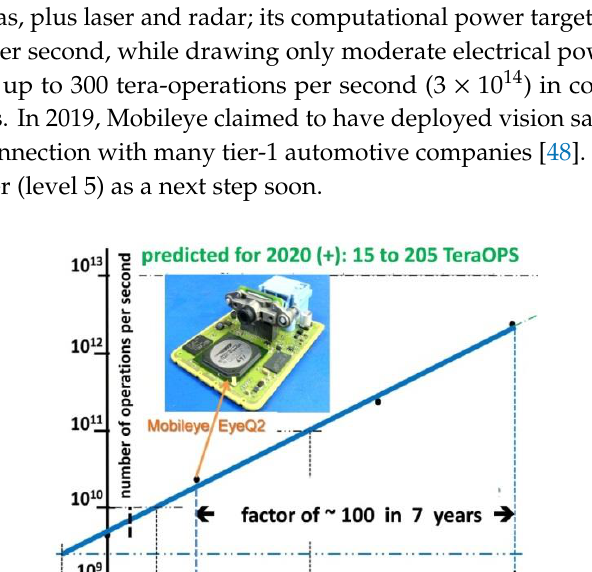
Figure 12. Agile multi-focal camera platform (left) as the main sensor, supported by a high-resolution 360° rotating laser scanner mounted on the roof (center). Right: Laser-image in perspective projection. UniBwM/LRT/TAS [51]. The interesting question is whether a vision system (as will be discussed in Section 4) allows one to get rid of the expensive LRF without losing the perception capabilities achieved up to now. It might even be possible to improve the perception capabilities of future vehicles up to the performance level of humans, especially in terms of more distant resolution details for the perception of color and texture. 2. Reasons behind the Differences between Biological and Technical Vision Systems Biological systems have evolved over millions of generations in carbon wetware with the selection of the fittest with respect to the ecological environment encountered; these systems are based on completely different properties of the underlying material as compared to technical vision